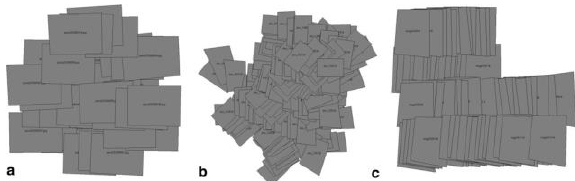
Figure 4: Different flight Patterns: a) manual mode, b) low-cost navigation system with irregular image overlap, and c) automated flying and acquisition mode (Nex and Remondino,